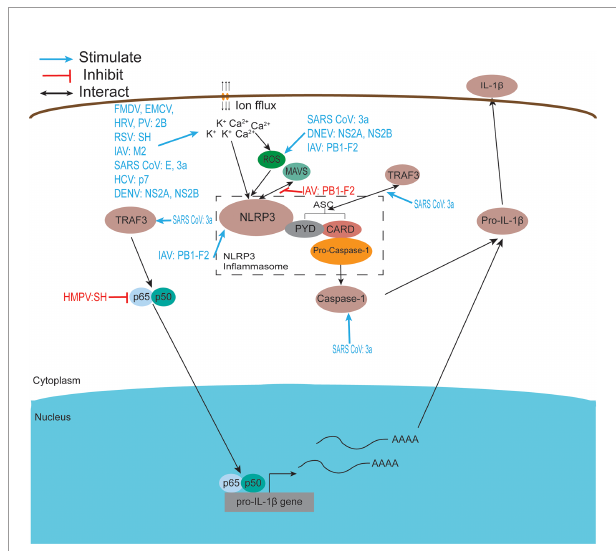
FIGURE 3 | Viroporins regulate in fl ammasome activation. The NACHT, LRR, and PYD domain-containing protein 3 (NLRP3) in fl ammasome is an oligomeric complex composed of the NOD-like receptor NLRP3, the adaptor protein ASC, and Caspase-1 (229). Mitochondrial damage, protein aggregation, and abnormal ion concentrations caused by viral infection can activate the NLRP3 in fl ammasome leading to the secretion of IL-1 b and IL-18. Most viroporins activate the NLRP3 in fl ammasome by disturbing intracellular ion concentrations. Some viroporins can activate NLRP3 through mitochondrial damage and increased ROS